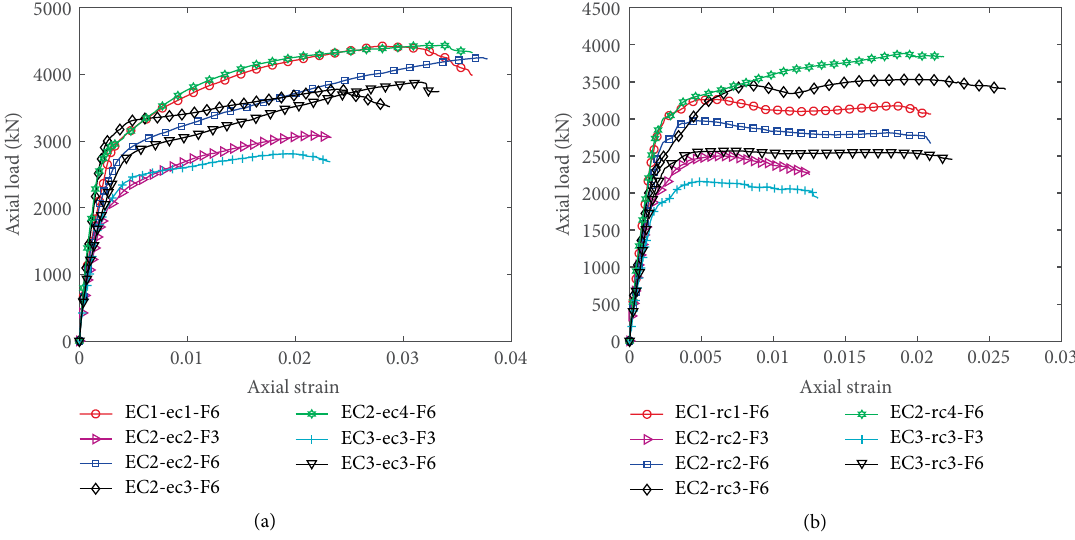
Figure 8: Axial load–axial strain curves. (a) EE-DSTCs. (b) ER-DSTCs.